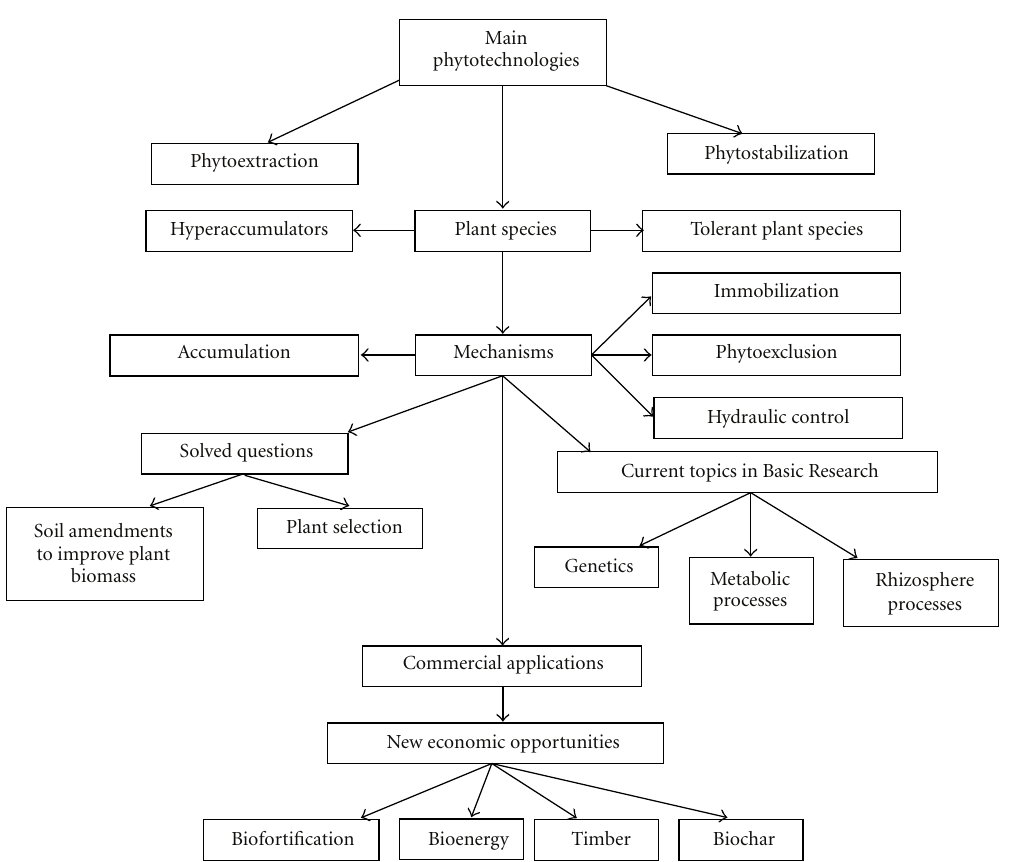
Figure 2: Phytostabilization and phytoextraction application. Current and future development.